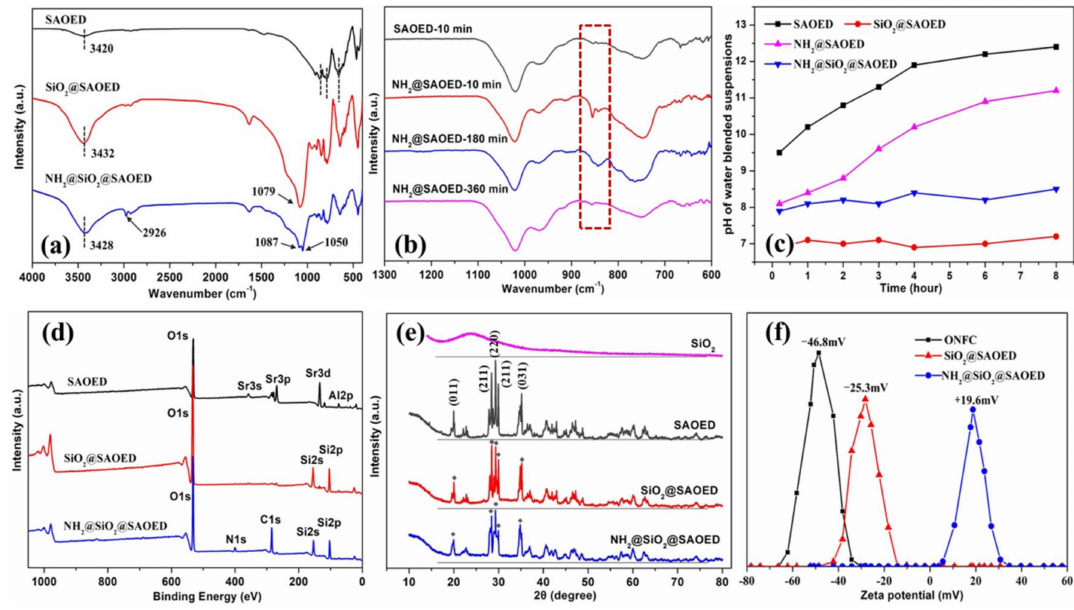
Figure 2. Chemical characteristics of SAOED phosphors before and after surface modification: ( a ) Fourier transform infrared (FTIR) spectra of SAOED, SiO 2 @SAOED, and NH 2 @SiO 2 @SAOED; ( b ) FTIR spectra of SAOED and pure APTMS-modified phosphors (NH 2 @SAOED) after immersion in water for different time; ( c ) pH values of different phosphor particle aqueous suspensions with different immersion time; ( d ) X-ray photoelectron spectroscopy (XPS) wide scan spectra of